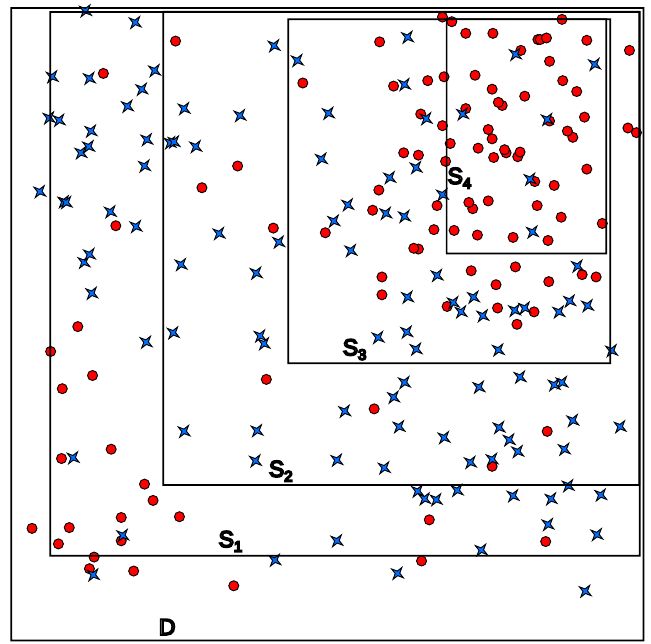
Figure 1. Peeling